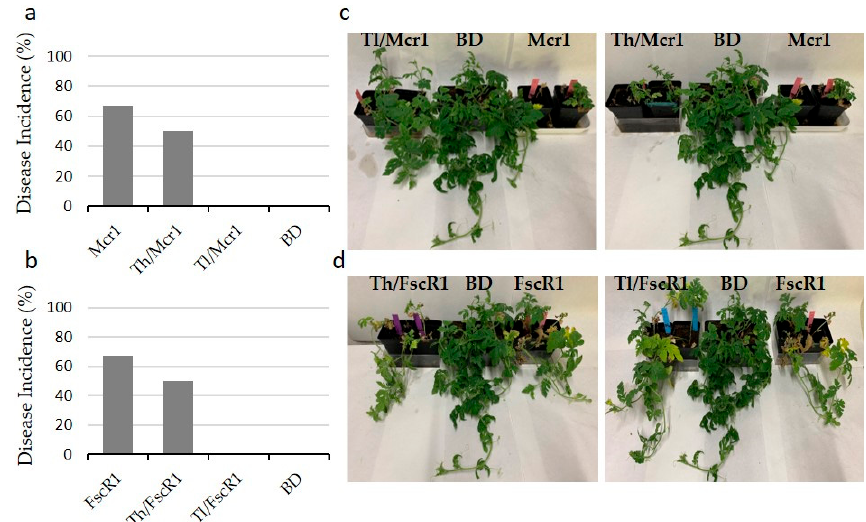
Figure 5. Comparison of protection e ff ects of Trichoderma strains, T. harzianum ( Th ) and T. lentiforme ( Tl ), in ‘Black Diamond’ watermelon plants (BD) against the cucurbit pathogens Macrophomina phaseolina ( Mcr1 ) and Fusarium solani f. sp. cucurbitaceae race 1 ( Fsc R1 ) when T. harzianum or T. lentiforme and these pathogens were inoculated simultaneously and individually in climatic chamber bioassay. ( a , b ): Disease incidence (%) of plants inoculation with Mcr1 or Fsc R1 alone or in combination with Th or Tl . ( c , d ): Response of the plants inoculated with Mcr1 or FscR1 alone or in combination with Th or Tl . BD represented watermelon plants without